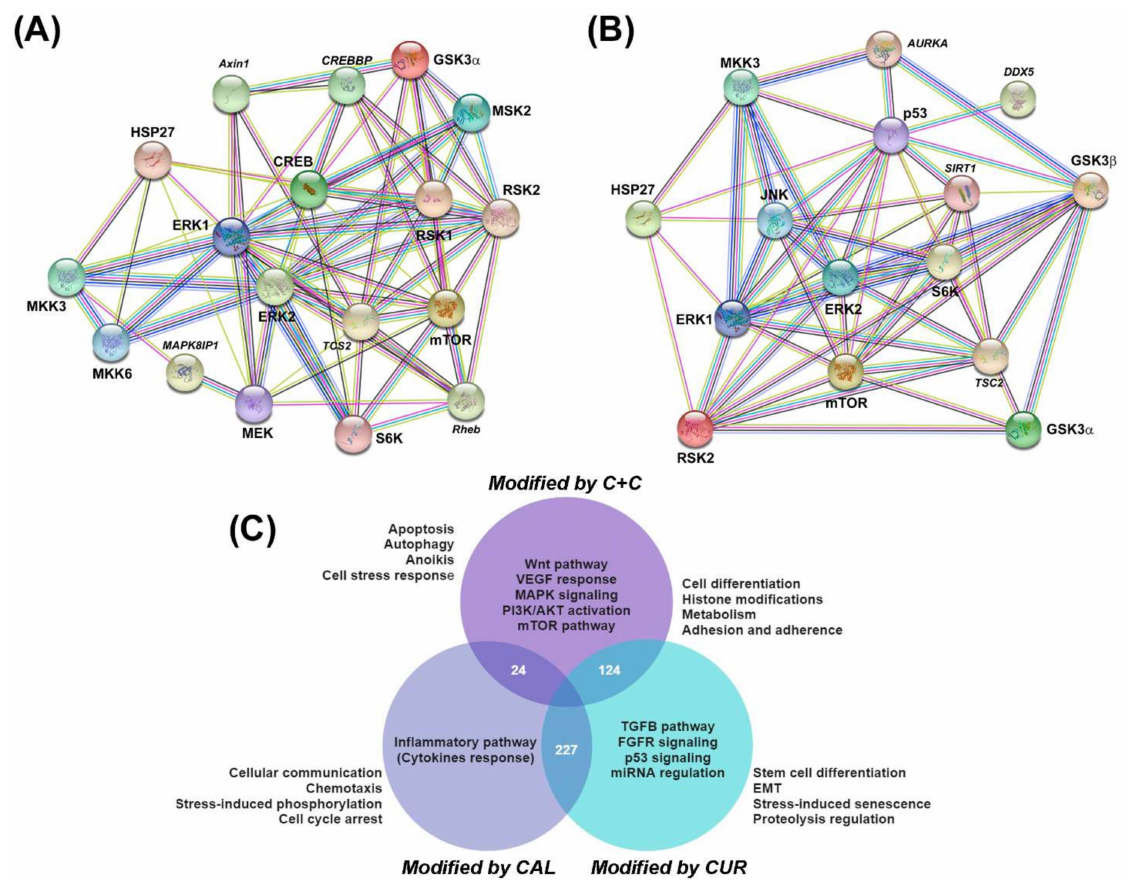
Figure 4. Interaction networks and biological processes regulated by calcitriol, curcumin or their combination involved in the anti-VM effect of the compounds. STRING analysis of deregulated kinases in calcitriol ( A ) or curcumin ( B ) treated co-cultures. Images in ( A , B ) show the physical and functional protein interactions. Protein names in italics represent the top predicted interactors of the network. ( C ) Prediction of the biological processes differentially regulated in each treatment group. A total of 227 processes were co-regulated by calcitriol (CAL) and curcumin (CUR); 24 processes were shared by the CAL and CAL+CUR (C+C), and 124 were shared in the CUR and C+C groups. Inside each circle, the main pathways involved are depicted. Outside, near each circle, the biological processes in which protein complexes were predicted to participate are